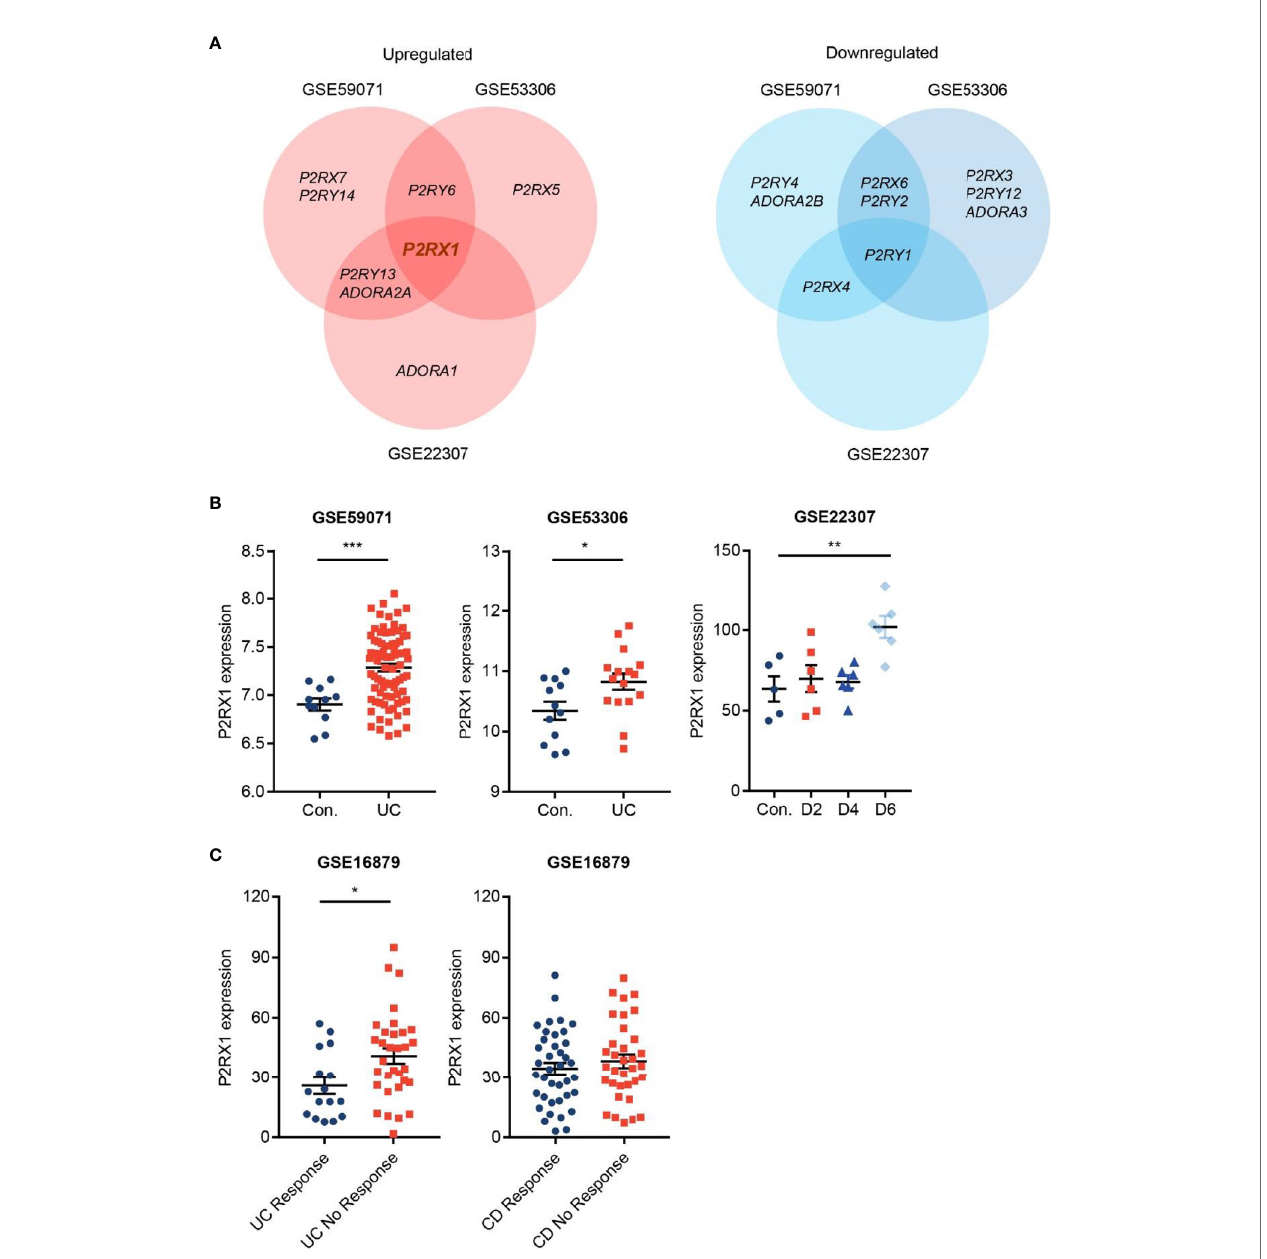
FIGURE 1 | Purinergic receptor P2RX1 expression is increased in activated colitis. (A) Expression of purinergic receptors were analyzed in two Gene Expression Omnibus (GEO) datasets (GSE59071 and GSE53306) containing expression pro fi le of actively in fl amed mucosa from colitis patients, and one GEO dataset (GSE22307) containing expression pro fi le of colon tissues from DSS-induced mouse colitis. Venn diagram of signi fi cantly upregulated and downregulated genes was shown. (B, C) Expression pro fi les of P2RX1 in the GSE59071, GSE53306, GSE22307, and GSE16879 datasets. *P < 0.05, **P < 0.01, and ***P <